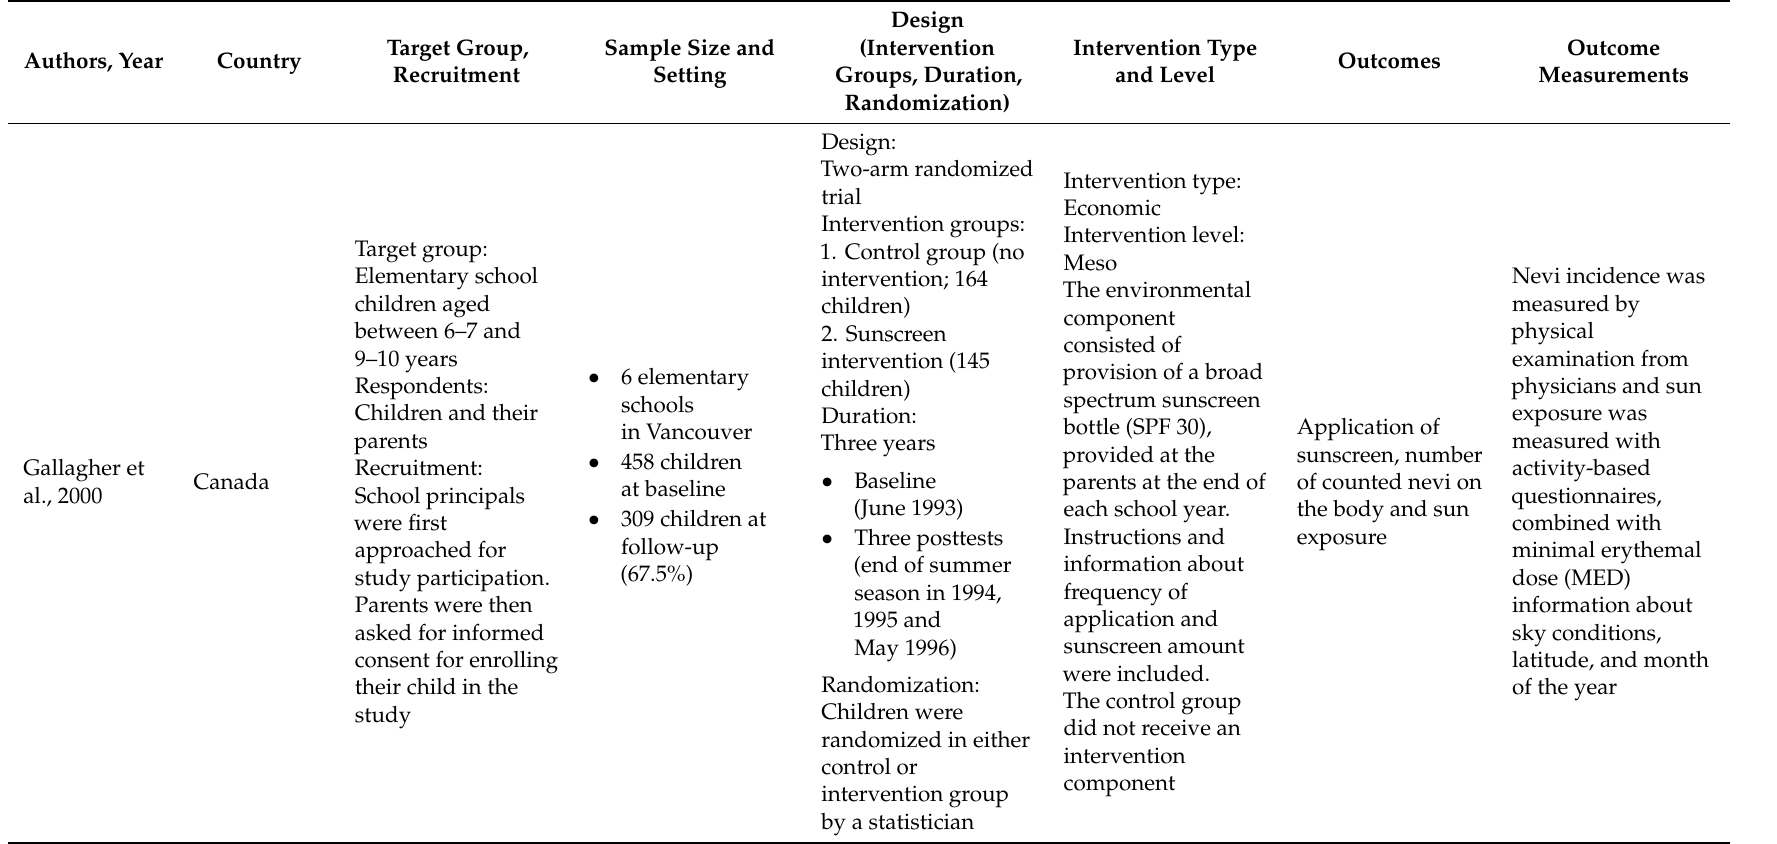
Table 2. Characteristics of studies included in the systematic